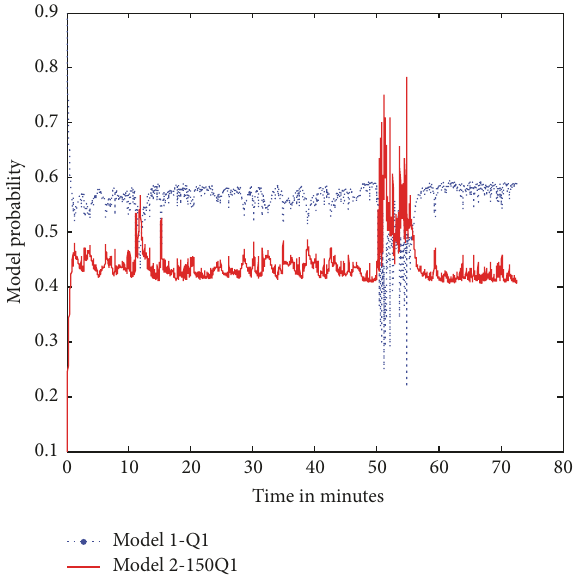
Figure 4: Model probabilities associated with the attack and ideal behaviour modes.